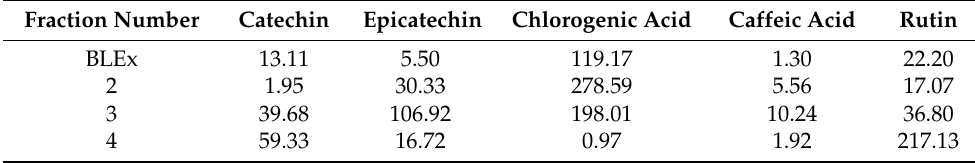
Table 2. Polyphenol composition of Fr. 2–4 and hot water